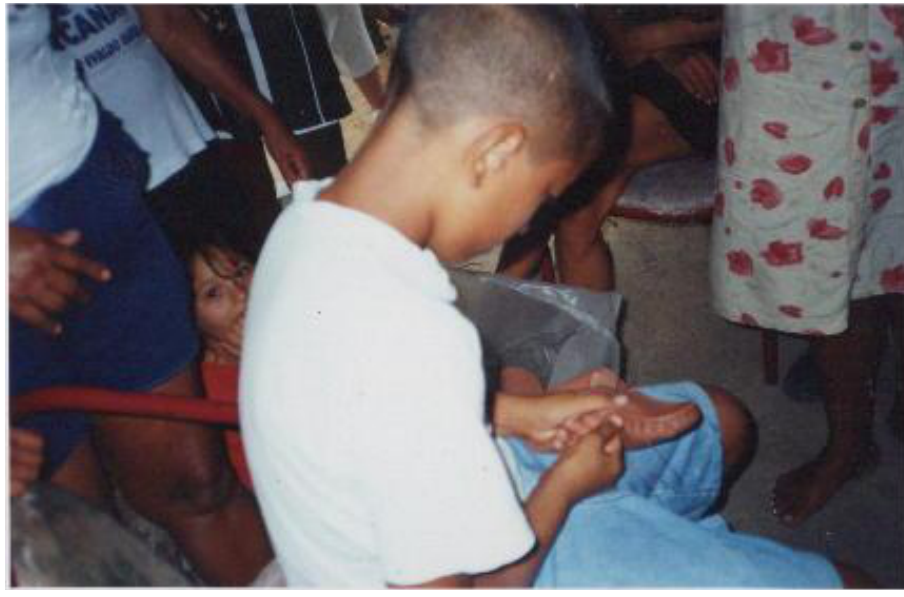
Figure 2. Child helping mother with domestic labor for footwear industry: fingers show the marks of stitching leather with a needle. (Photo provided by Iara